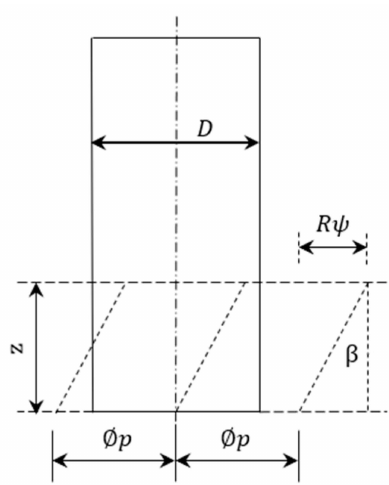
Figure 4. Flat-end milling cutter